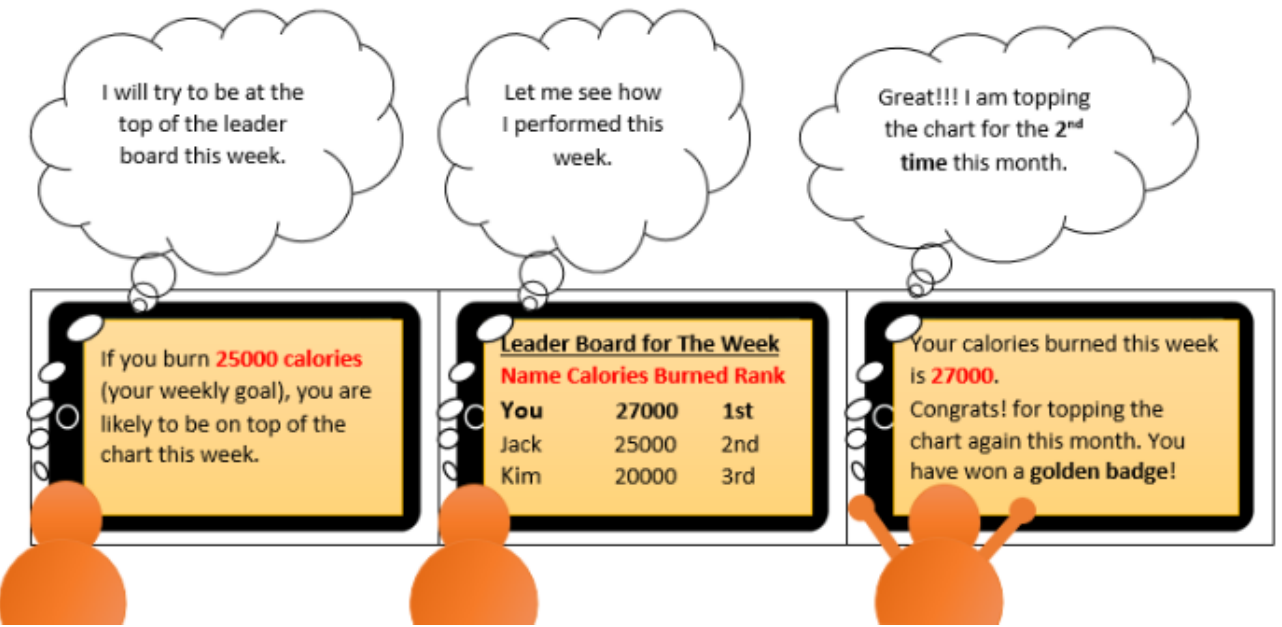
Figure A3. Low-fidelity storyboard illustrating the Cooperation feature of the fitness app [30].